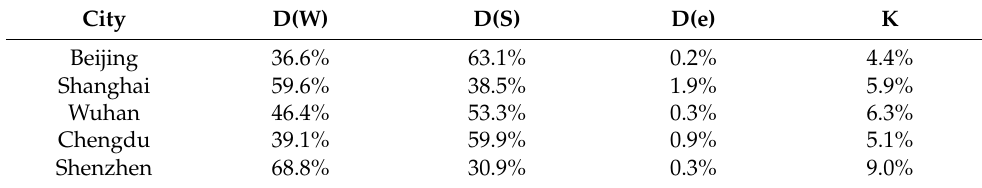
Table 2. Contributions of different components to the total variances of MDA8 O 3 in five cities. City D(W) D(S) D(e) K 36.6% 63.1% 0.2% 4.4% 59.6% 38.5%